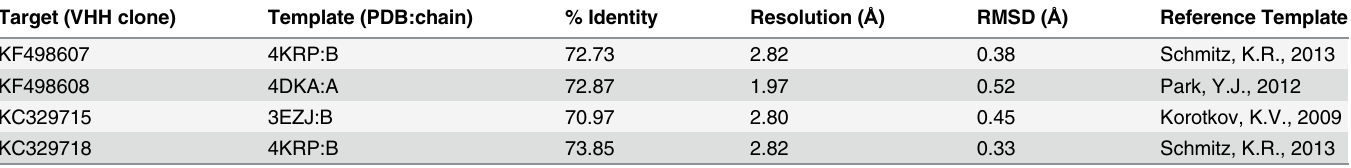
Table 3. PDB code, resolution, references, percent similarity and RMSD of templates for modeled VHHs. Target (VHH